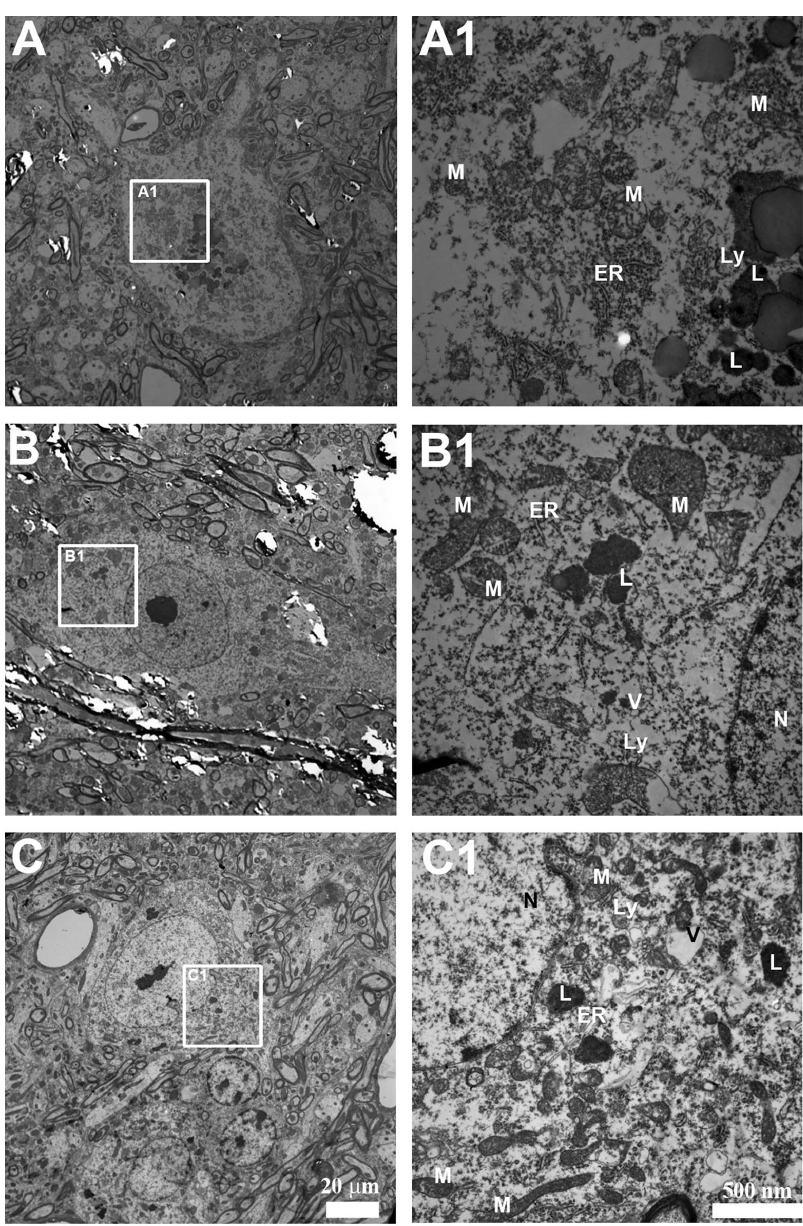
Figure 8. Ultrastructural deficits in the cell body of motor neurons using TEM. Representative images of motor neurons in A, A1) Sod1 + / + mice at 20 mo, B, B1) Sod1 2 / 2 mice at 20 mo, and C, C1) Sod1 + / + mice at 30 mo. Scale bar=20 m m (A, B, and C) and 500 nm (A1, B1, and C1). ER=endoplasmic reticulum; L=lipofuscin; Ly=lysosome; M=mitochondria; N=nucleus; v=vacuoles.